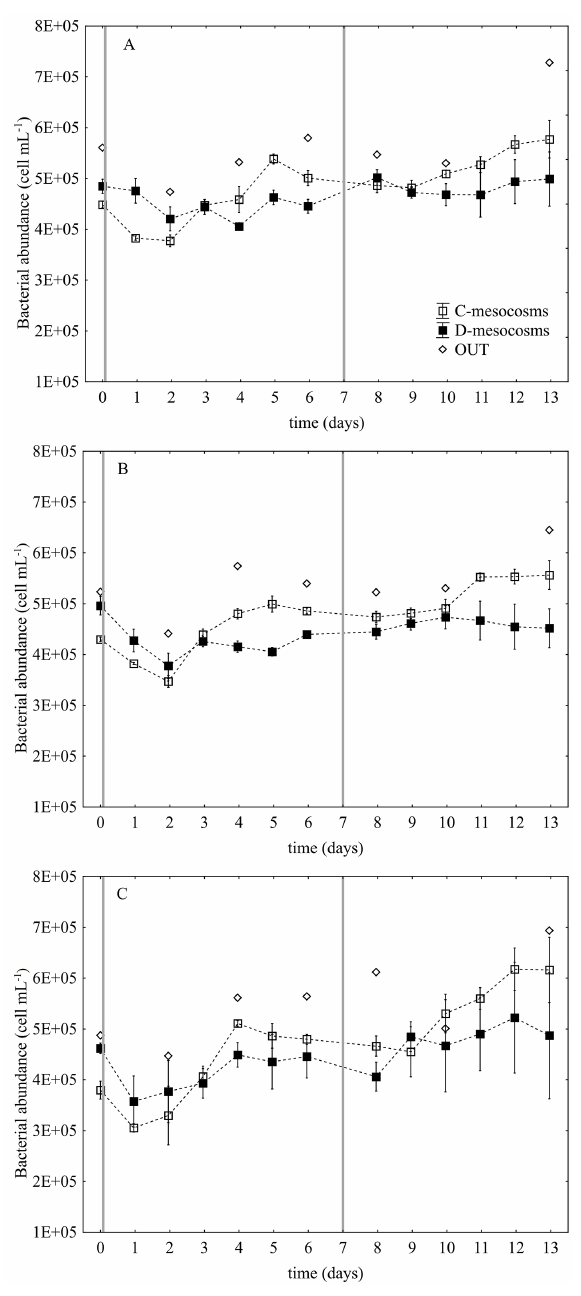
Figure 1. Dissolved inorganic phosphorus (nM, mean ± standard deviation of three replicate mesocosms) in D- and C-mesocosms and OUT samples at surface (a) , 5m (b) and 10m (c) depth dur- ing the DUNE-R experiment. Grey vertical bars represent the dust seedings.